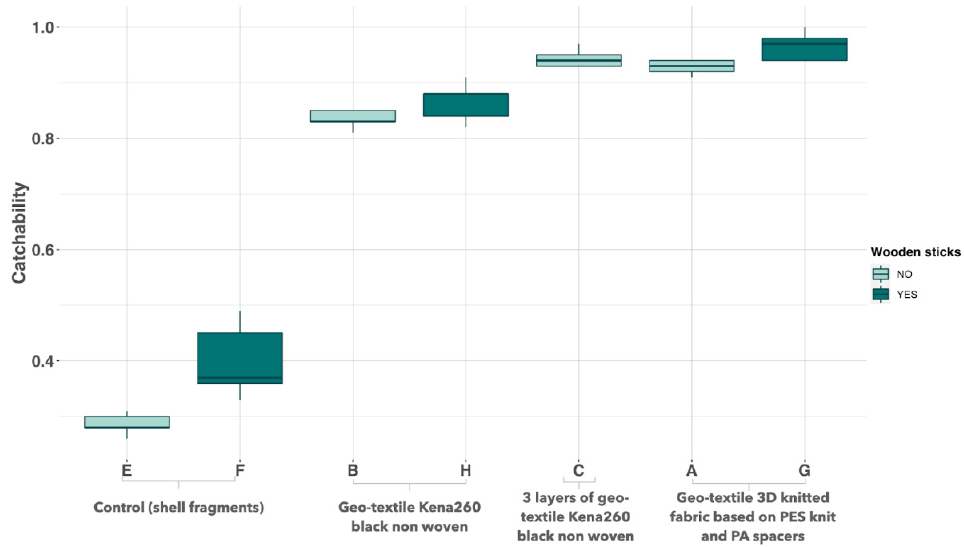
Figure 8. Box plot of the capture properties of each substrate based on plastic pellet catch rate (slope of the linear model volume of particle~time), with four replicates for each treatment. Colour represents the presence/absence of wooden sticks on the substrate.